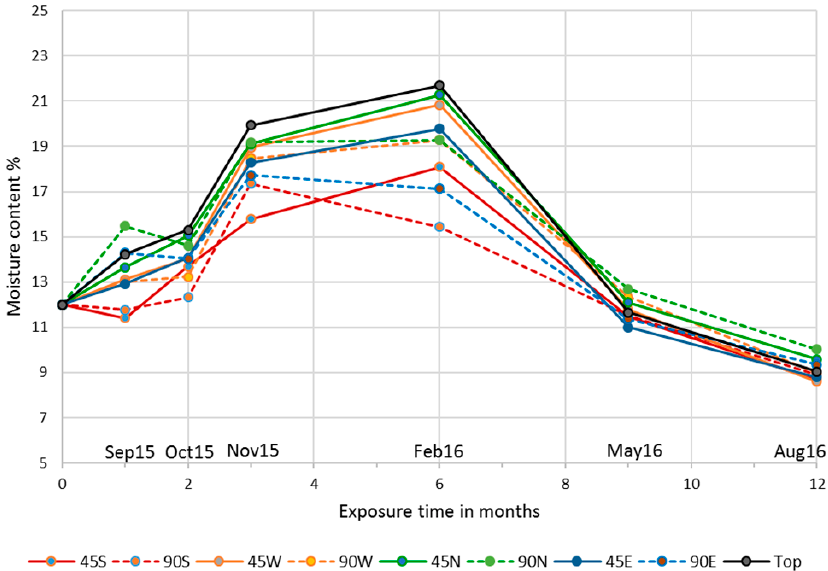
Figure 13. Influence of cardinal direction and the angle of exposure on the moisture content of samples coated with the ICP clear (two coats) exposed on the MFER.